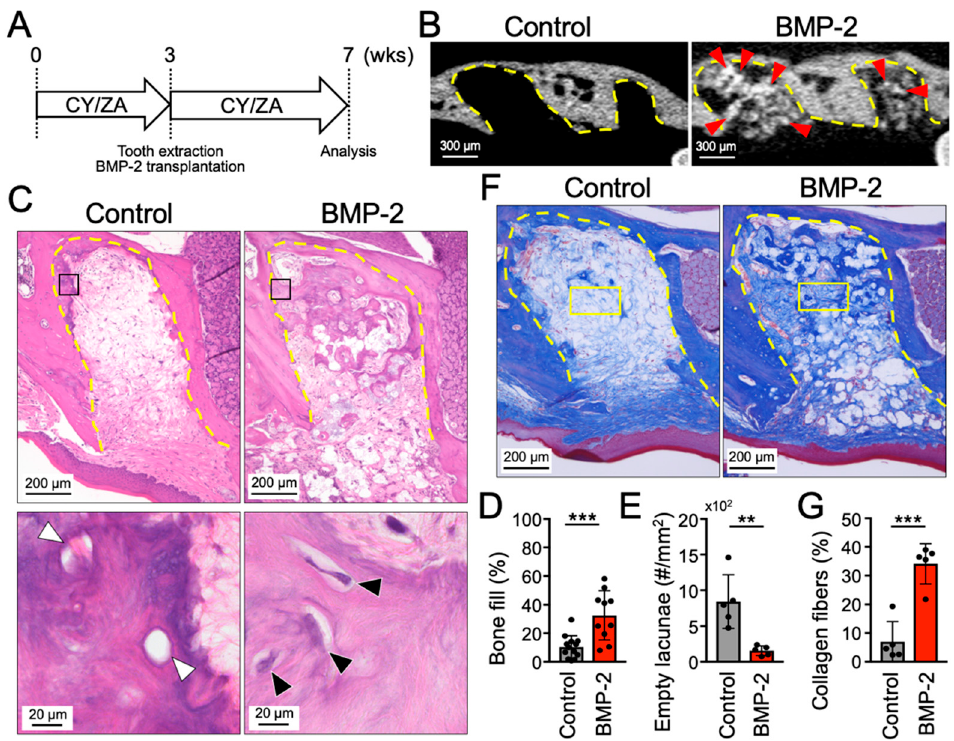
Figure 2. Transplantation of BMP-2/ β -TCP partially induced bone formation in tooth extraction socket in a medication-related osteonecrosis of the jaw (MRONJ) prevention model. ( A ) Experimental design. BMP-2/ β -TCP was transplanted into the extraction socket of the maxillary first molar after 3 weeks of CY/ZA administration in mice. CY/ZA administration was performed throughout the study period. ZA: zoledronate, CY: cyclophosphamide. ( B ) Sagittal images of micro-CT and ( C ) HE-stained sections, 4 weeks after transplantation. Lower panels are high magnification images of the squares in the upper HE-stained images. ( D ) The bone-fill rate in the tooth extraction socket and ( E ) the number of empty lacunae in the regenerated bone are shown in graphs, respectively. Bars represent the mean values and standard deviation (+/ − SD) ( n = 5–13). (** p < 0.01, *** p < 0.001. Student’s t -test). ( F ) Sagittal view of the tooth extraction socket stained with Masson’s trichrome, 4 weeks after transplantation. Yellow boxes indicate the total measured area for calculation of the ratio between the collagen fiber area and the total measured area. ( G ) The percentage area of the collagen fibers in the center of the tooth extraction socket is shown in the graph. Bars represent the mean values and standard deviation (+/ − SD) ( n = 5). (*** p < 0.001. Student’s t -test). Red arrowheads indicate the residual β -TCP. Black and white arrowheads indicate the osteocytes and empty lacunae, respectively. Yellow dashed lines indicate the tooth extraction socket.